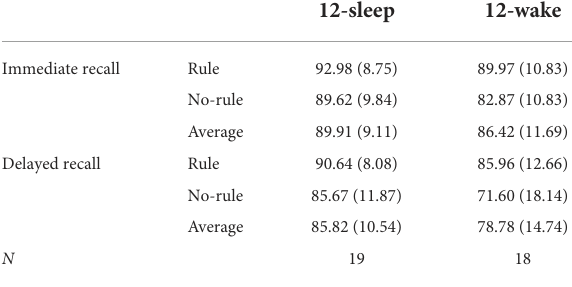
TABLE 1 Percentage of correctly recollected face-location associations at immediate and delayed testing in experiment 1 (mean percentage and